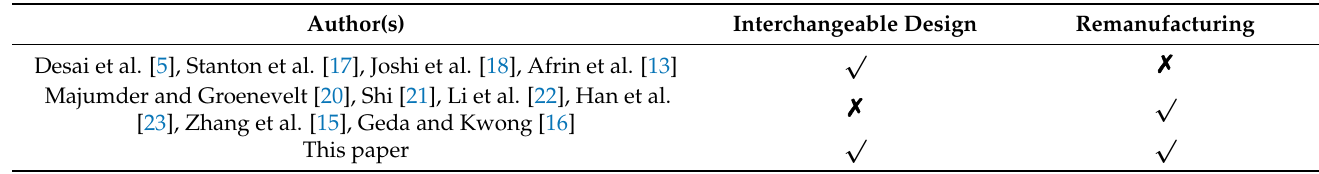
Table 1. Comparison of this study with related research.